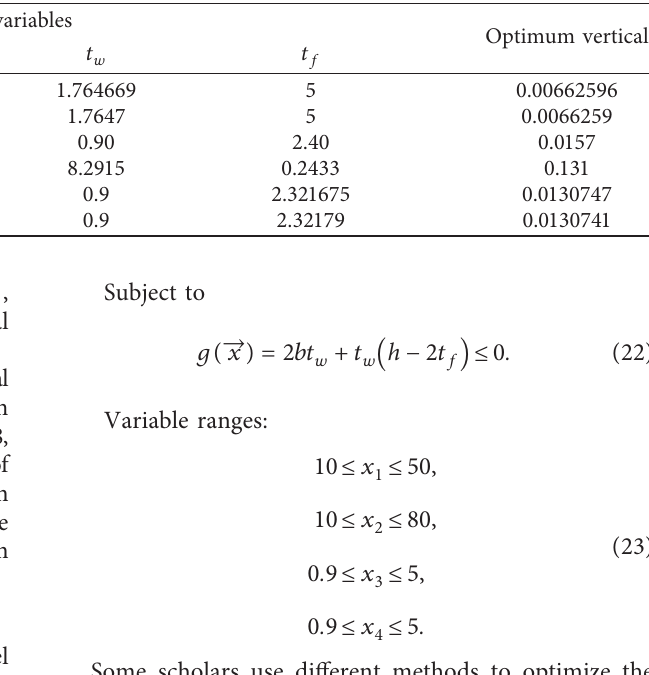
Table 12: Comparison of the GCLPSO with other methods for the I-beam design